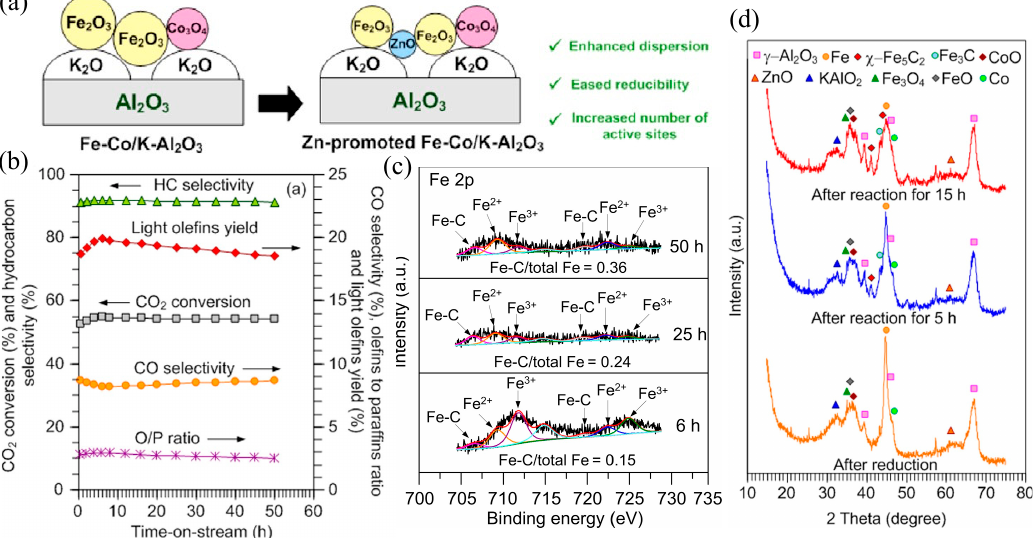
Figure 12. ( a ) Illustrated reaction mechanism. ( b ) Catalytic performance of the CO 2 hydrogenation over a Zn-promoted Fe-Co/K-Al 2 O 3 catalyst. ( c ) XPS spectra (Fe 2p region) of the 0.58 wt% Zn-promoted Fe-Co/K-Al 2 O 3 catalysts. ( d ) XRD pattern of the 0.58 wt% Zn-promoted Fe-Co/K-Al 2 O 3 catalyst at varying TOS. Testing conditions: T = 613 K, P = 25 bar, GHSV = 9000 mL g cat − 1 h − 1 and H 2 /CO 2 molar ratio = 4. Adapted with permission from ref. [89]. Copyright 2021 Elsevier.